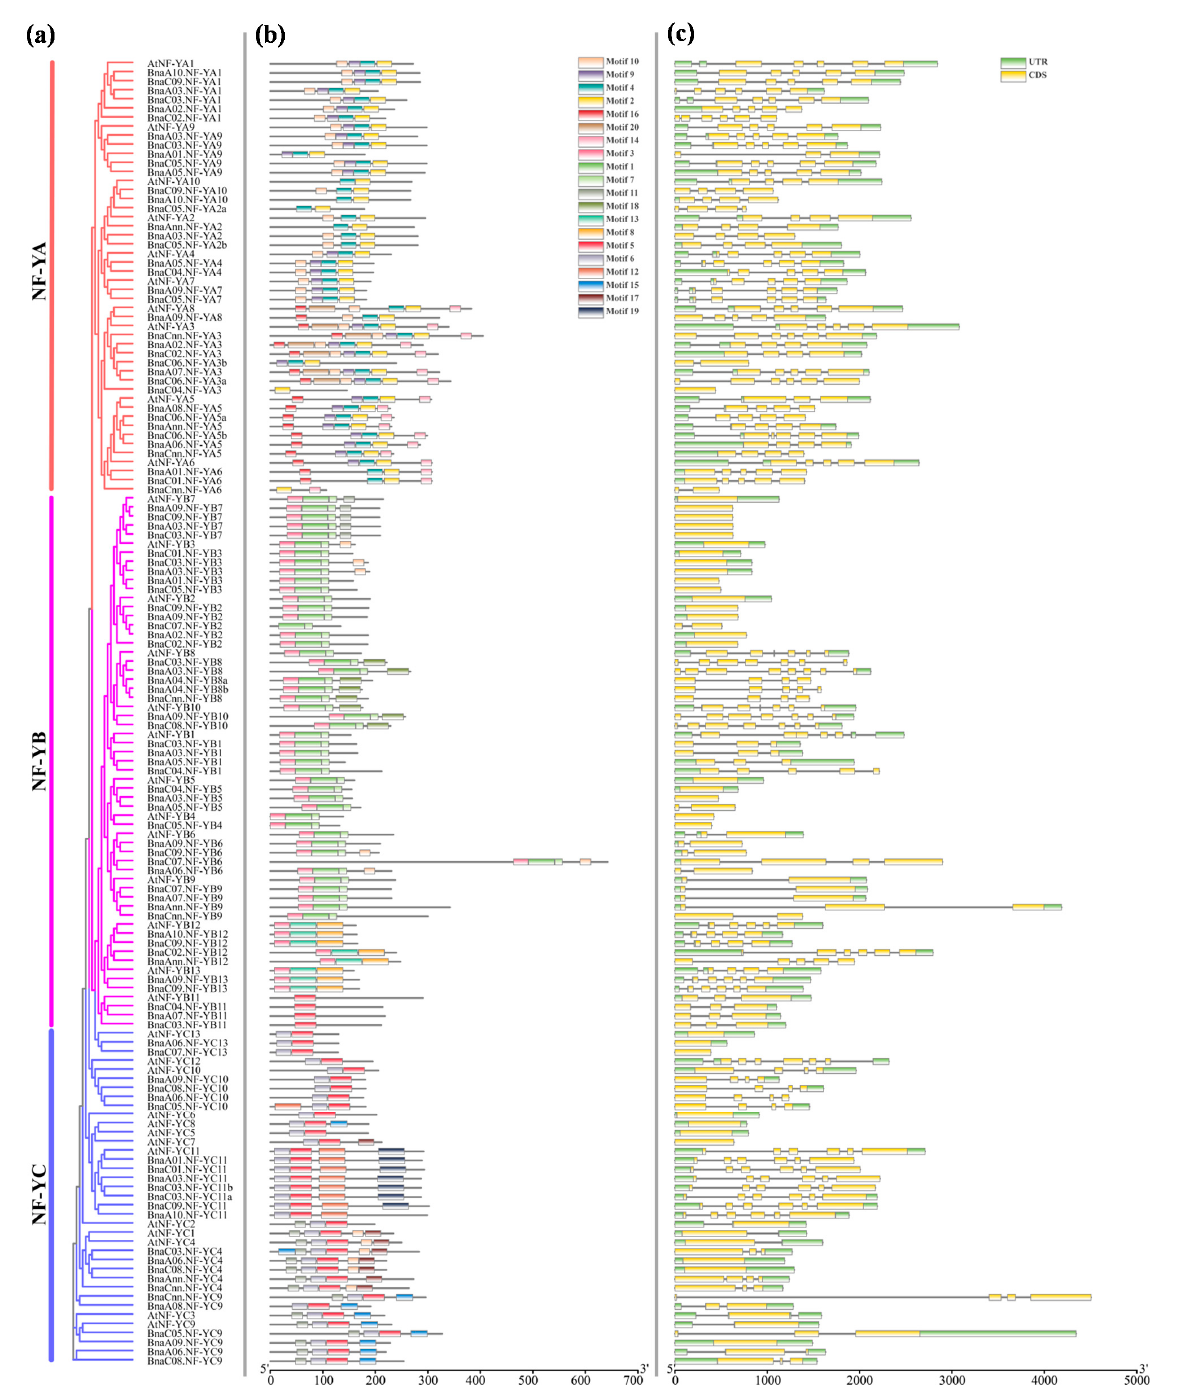
Figure 4. Phylogenetic relationships, gene structure and conserved motif compositions of the NF-Y family in B. napus and Arabidopsis . ( a ) The phylogenetic relationships of the BnaNF-Y and AtNF-Y genes. The 108 genes of B. napus and 36 genes of Arabidopsis are divided into three groups; ( b ) Conserved motif compositions. Each colored box in the middle represents a motif, and the black line represents non-conserved sequences; ( c ) Gene structure. The untranslated region (UTR), exon and intron in the right of each subfamily are represented by a green box, yellow box and gray line, respectively.